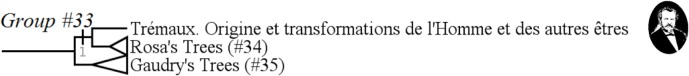
Subtree showing the group #33 (called “Theoretical genealogies”).